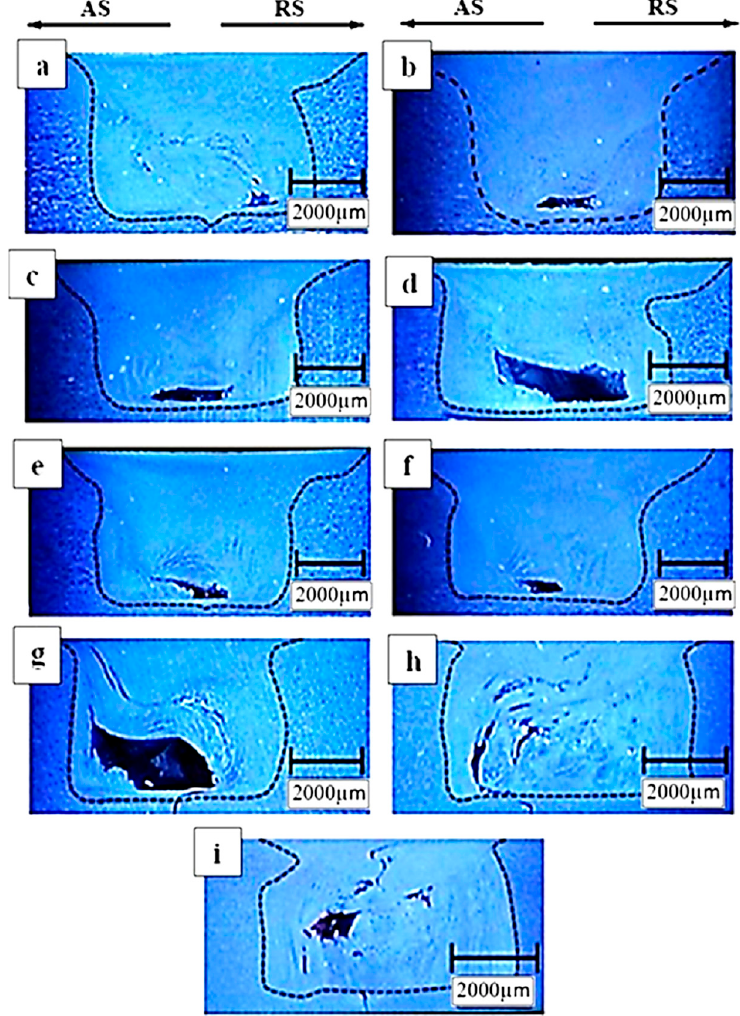
Figure 7. Cross-section of the defective welds with rotational and traverse speeds of ( a ) 500 rpm, 41.5 mm/min; ( b ) 500 rpm, 80 mm/min; ( c ) 500 rpm, 125 mm/min; ( d ) 800 rpm, 41.5 mm/min; ( e ) 800 rpm, 80 mm/min; ( f ) 800 rpm, 125 mm/min; ( g ) 1600 rpm, 41.5 mm/ min; ( h ) 1600 rpm, 80 mm/min; ( i ) 1600 rpm, 125 mm/min [106]. Reprinted from: Study on the effects of friction stir welding process parameters on the microstructure and mechanical properties of 5086-H34 aluminum welded joints.